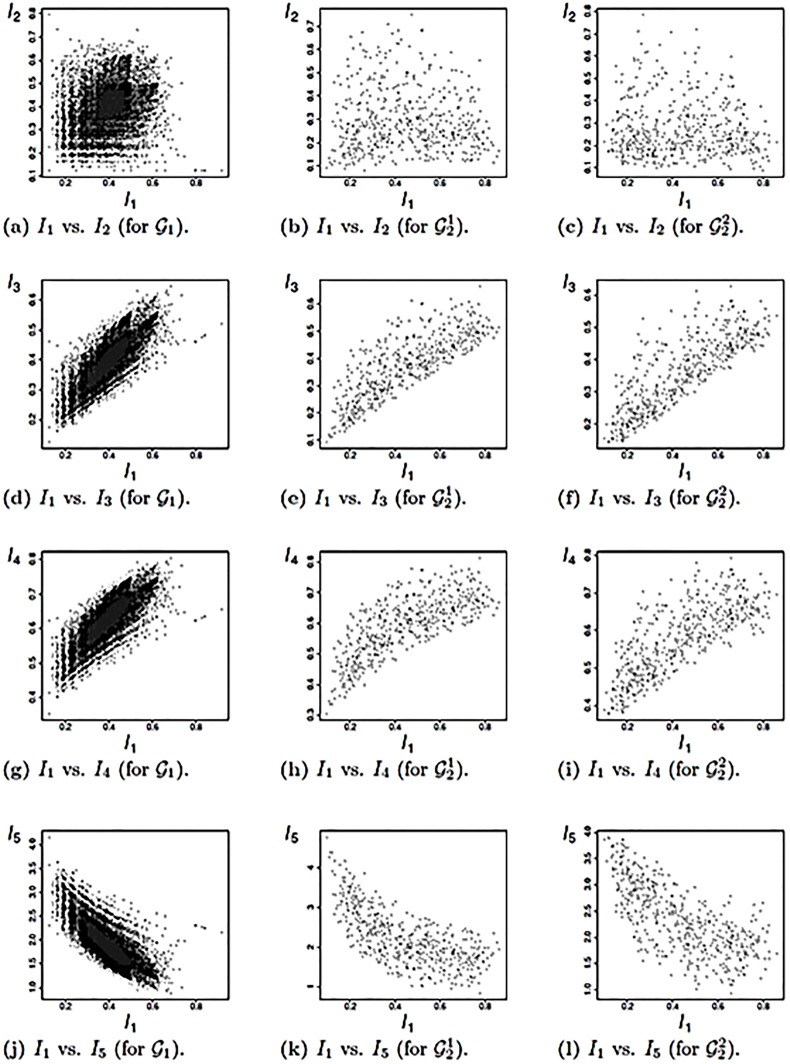
Scatter plots for I1 vs. Ij, 2 ≤ j ≤ 5.